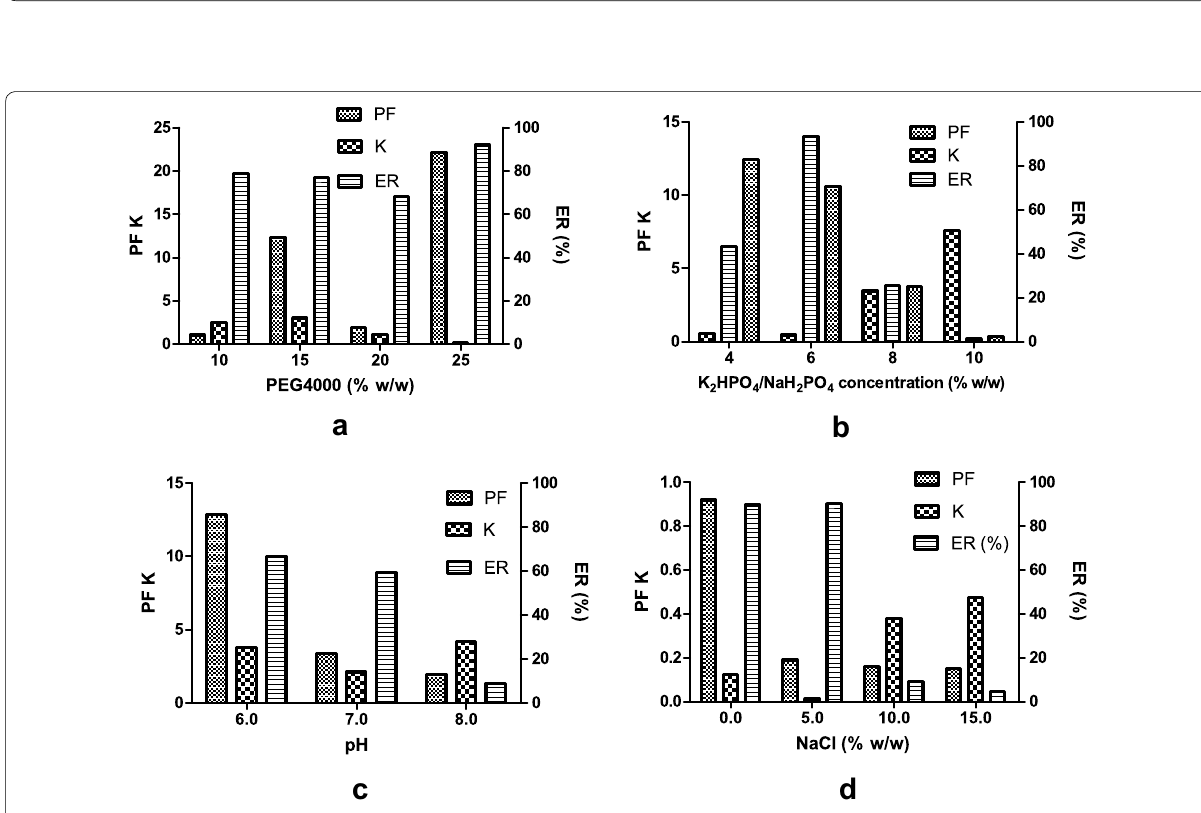
Fig. 6 Effect of PEG 4000, NaCl concentration, and pH on purification of endoglucanase from supernatants of pET21-egls/DE3 cells. PF purification factors, K partition coefficient, ER enzyme recovery. a PEG 4000 (10–25%, w/w); b K2HPO4/NaH2PO4 (4–10%, w/w); c pH (6.0–8.0); d NaCl (0–15%,